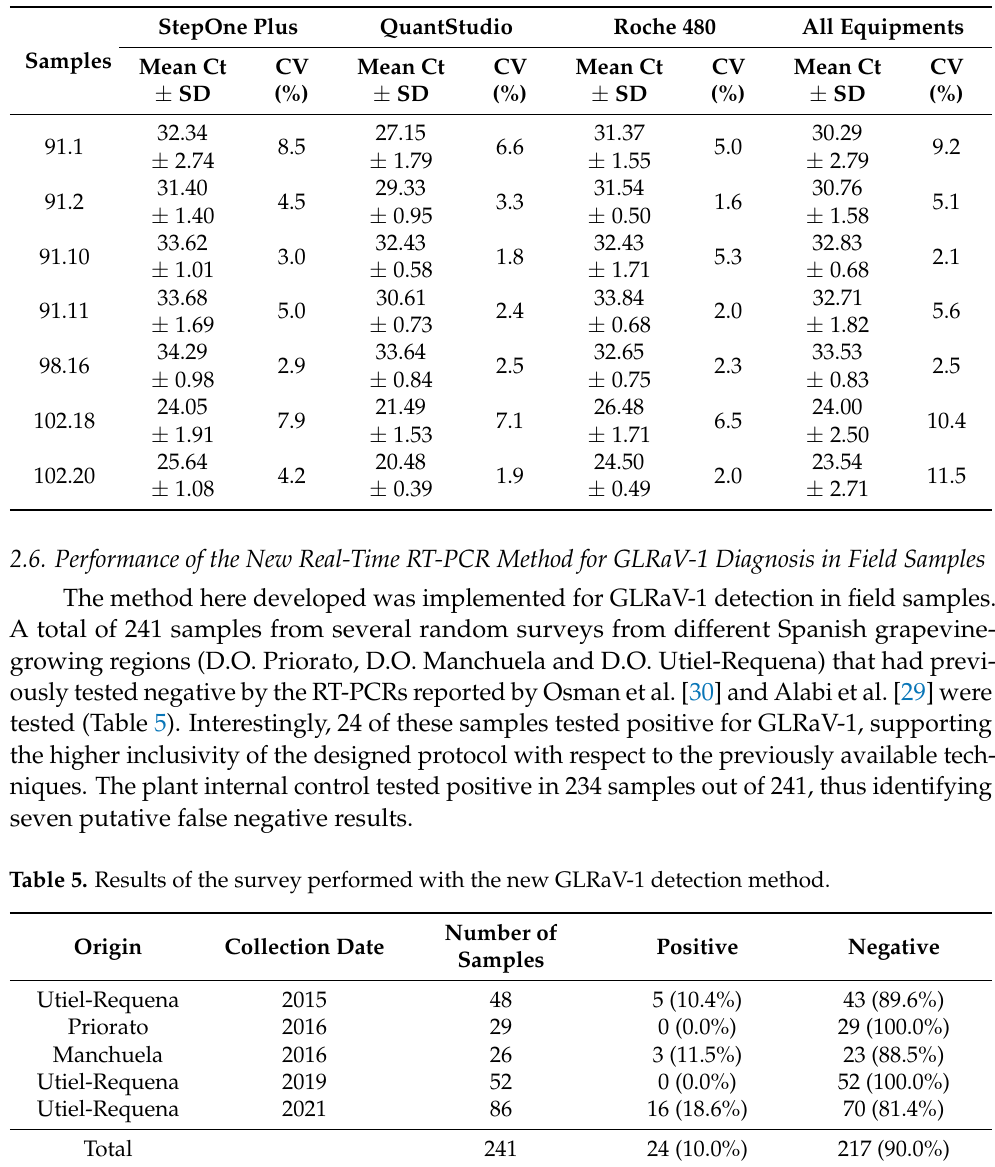
Table 4. Evaluation of repeatability and reproducibility of the quantitative real-time RT-PCR. Mean Ct values, standard deviation and coefficient of variation (CV) between replicates performed in the same thermal cycler and between all replicates are shown.